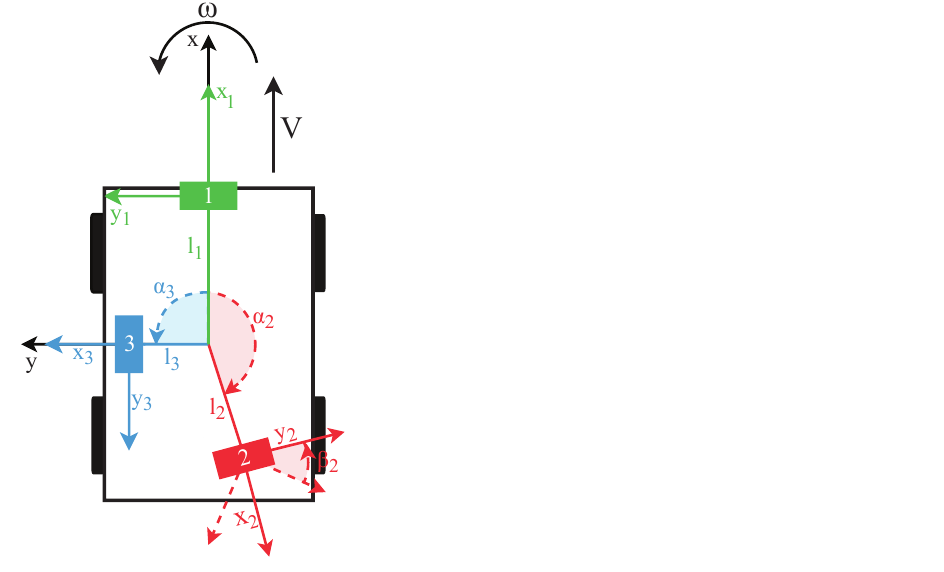
Figure 3. Drawing of a mobile platform seen from the top with three eRTIS sensors. Each is described by the distance l from the platform’s rotation center point, the angle α around on the XY-plane relative to the x-axis, and the angle β which describes the local rotation of the sensor around its own center. The only constraint is that all sensors must be located roughly on the same horizontal